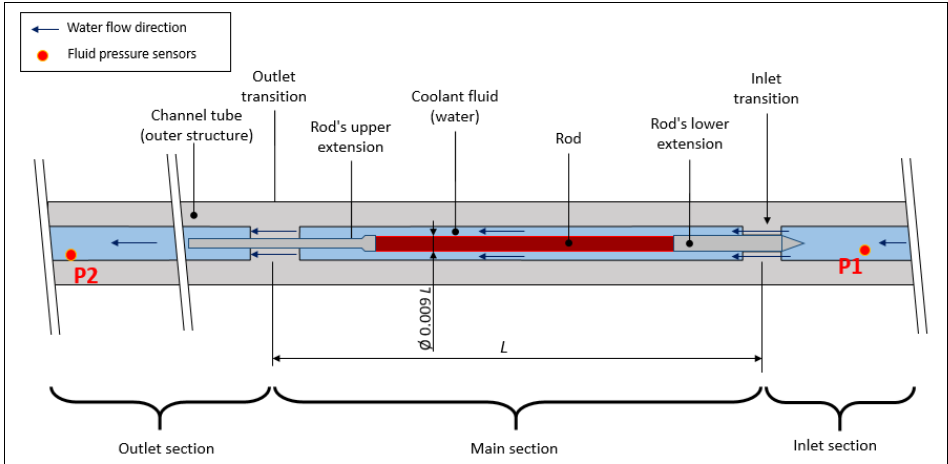
Figure 1. Simplified drawing of the test device (fuel rod in red, other structural parts in gray, and fluid in blue). Dimensions are relative to the length of the main section, L ∼ 1 m. The most external tube and the gaseous gap are not